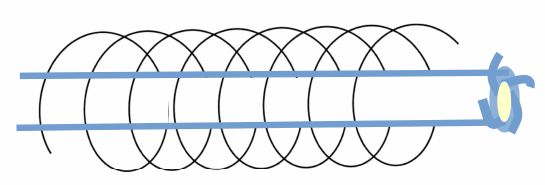
Figure 5. At large distance from any galaxy, movement along cosmic web filaments is helicoidal. This is well known from the movement along a B field in electrodynamics; the difference here is that not only charged particles, but also neutral objects (whether gas or any sort of aggregate), by the equivalence principle, follow the helix. The trajectory is stretched by the galaxy upon approaching it when the acceleration due to the extra mass at the end is